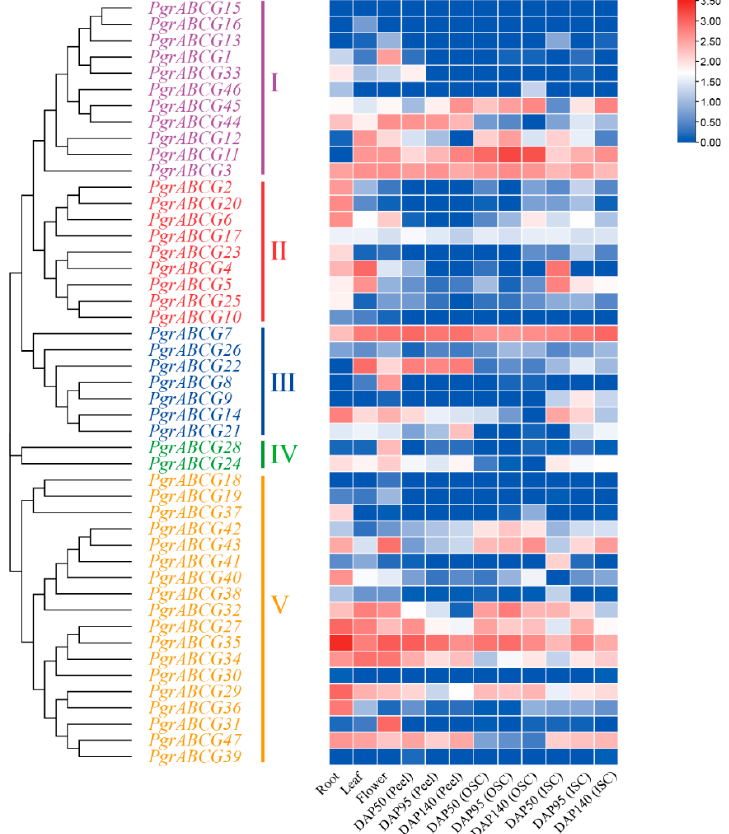
Figure 2. Expression profile of PgrABCG genes in different tissues of pomegranate based on RNA-Seq data. The transcript data were calculated with log2 normalization based on FPKM values. “DAP” = days after pollination, “ISC” = Inner Seed Coat, “OSC” = Outer Seed Coat.